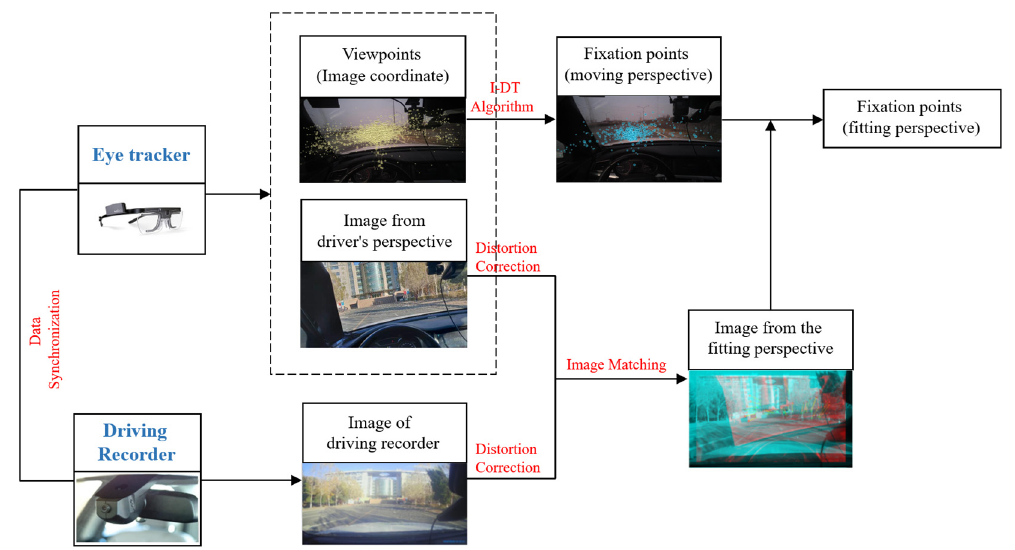
Figure 3. Data processing flow.